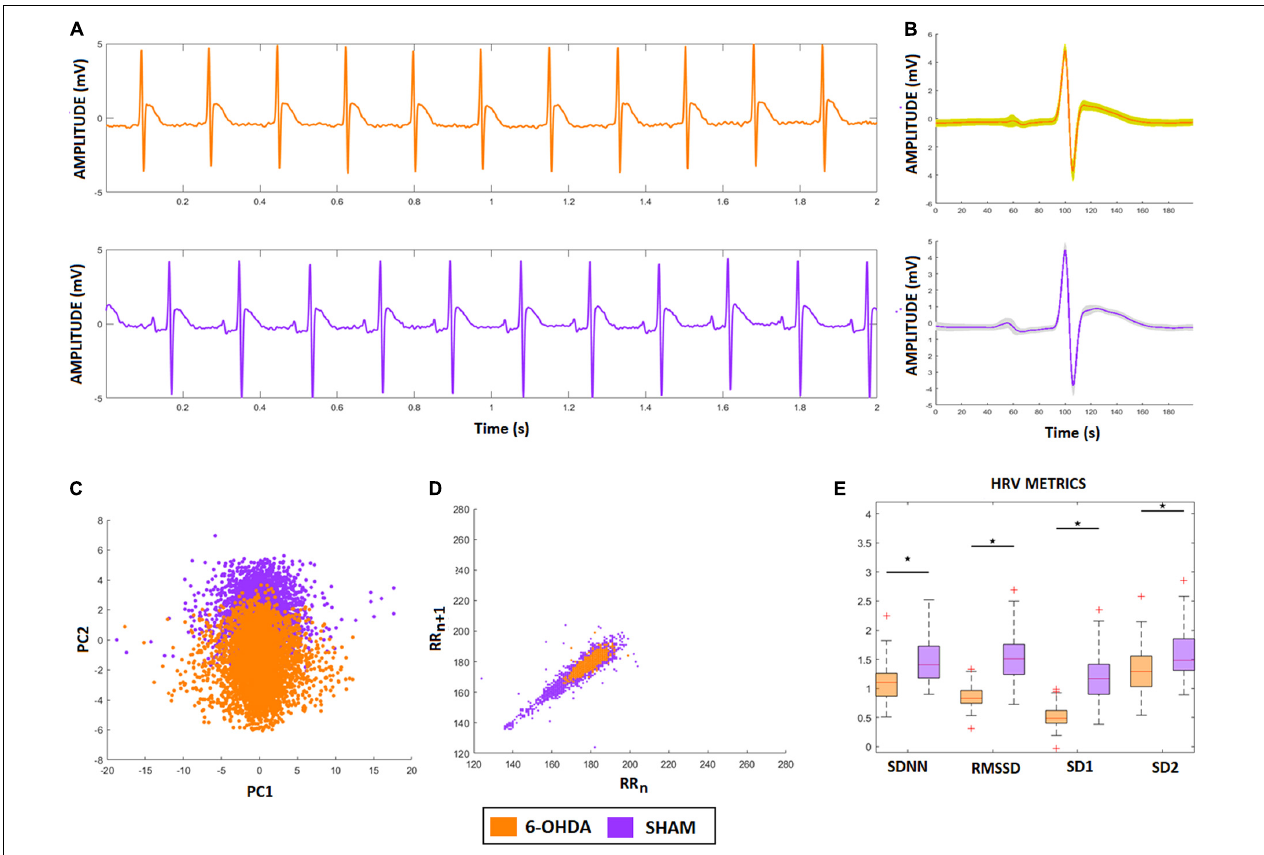
FIGURE 6 | ECG and HRV standard features from animal model. (A) ECG signals from both animal models, 6-OHDA in orange and Sham in lilac. (B) Morphologic differences of PQRST-complexes. (C) Principal Component Analysis of PQRST complex, it is possible to see two clusters, one in orange and one in lilac. (D) Poincaré plot of both ECG recordings, showing that 6-OHDA group has a denser cluster. (E) HRV coefficients for each group, all characteristics presented significative difference ( ρ < 0.05), by comparing 6-OHDA with Sham